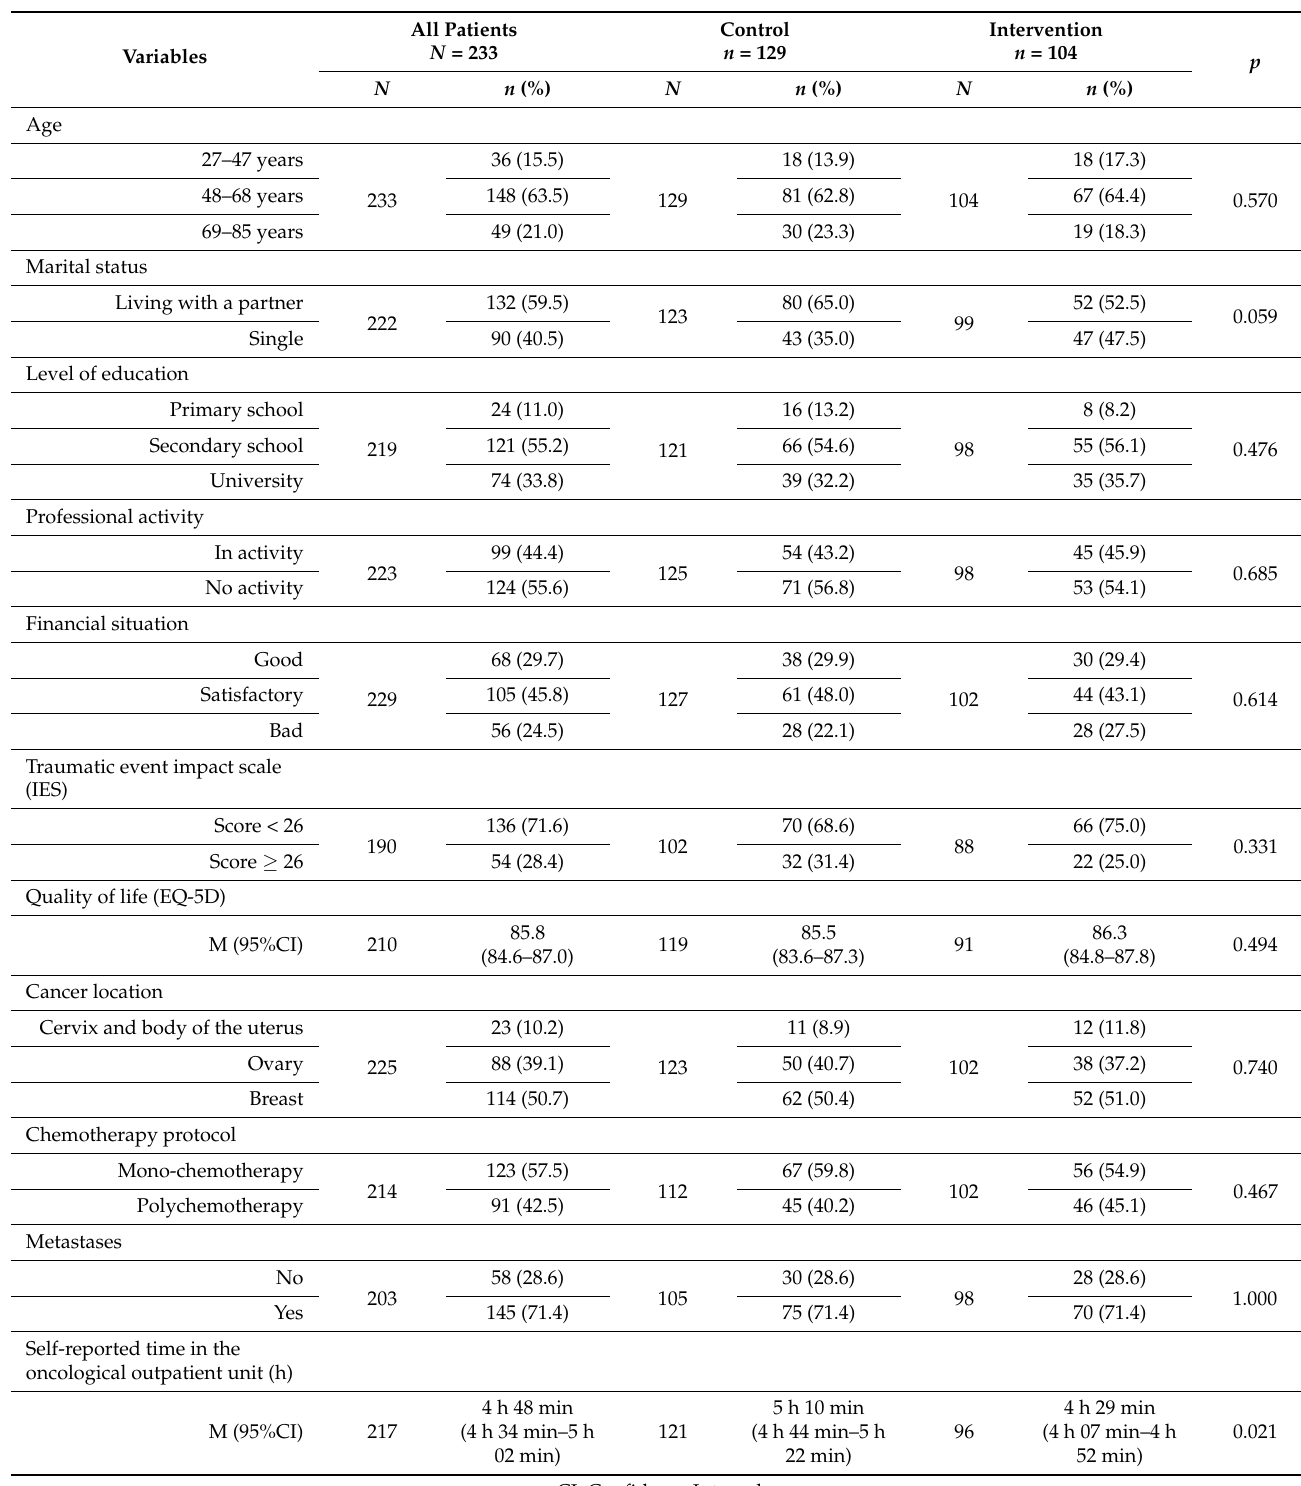
Table 1. Description of the sample and comparison between the two groups (control vs.